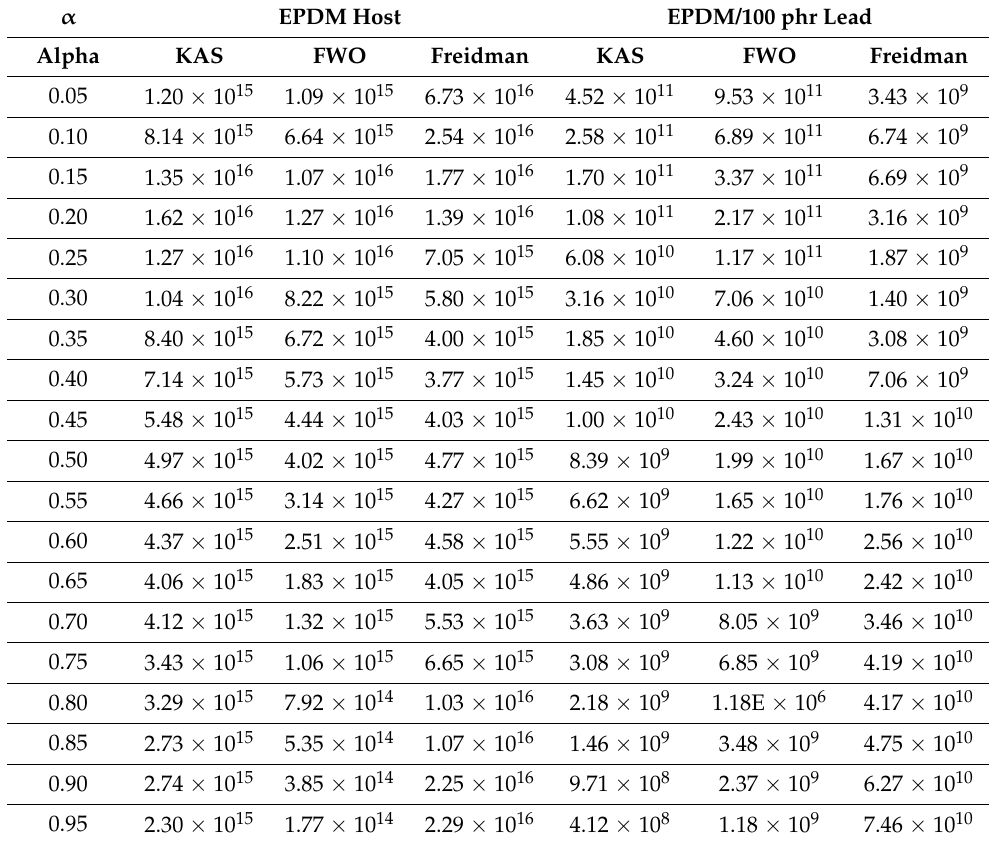
Table 6. The pre-exponential factor calculated using three methods for the host composite (0 phr lead) and composite loaded with 100 phr